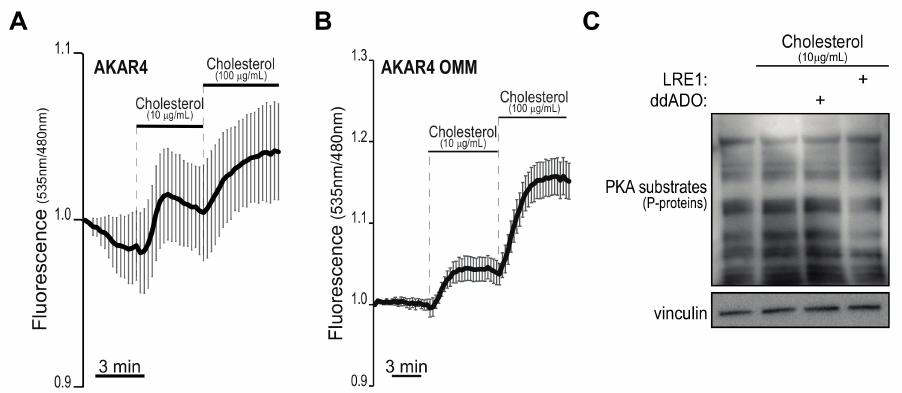
Figure 3. Cholesterol supplementation induces rapid PKA activity predominantly in proximity of sub-cellular organelles. ( A , B ), Pancreatic acinar cells were isolated from wild-type animals, infected with adenoviral vectors encoding for the PKA sensors AKAR4 (that senses cytoplasmic PKA activity, panel ( A ) and AKAR4-OMM (that targets PKA activity localized on the surface of intracellular organelles, panel ( B ). After 36 h, cells were embedded in a synthetic matrix and imaged. Fluorescence intesities were recorded for several minutes, before and after the addition of indicated amounts of cholesterol. The graphs show FRET ratios over time. Scale bars, 3 min. In ( C ), primary acinar cells were added cholesterol or vehicle and immediately treated with indicated inhibitors (30 µ M both) for 15 h. Whole-cell lysates were blotted to detect phosphorylated PKA